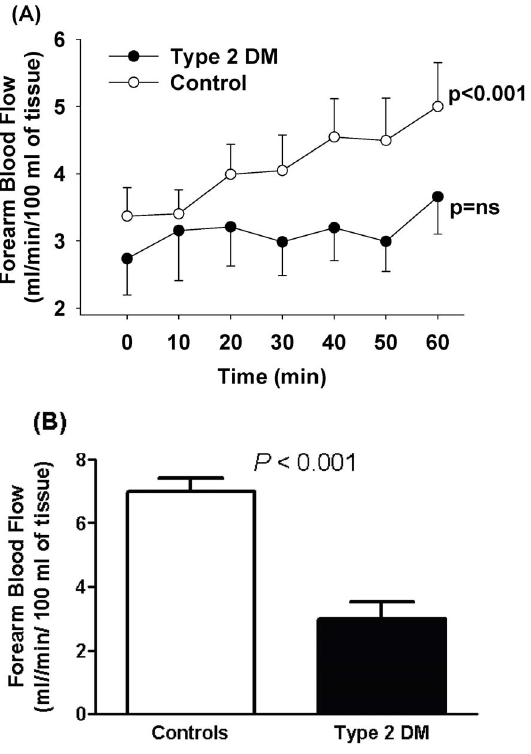
Figure 1. ( A ) Forearm blood flow responses to intra-arterial insulin infusion in controls (n=11) and type 2 diabetic subjects (n=9). Symbols and error bars represent mean 6 SEM. P values refer to 1-way RM ANOVA statistic. Type 2 DM, subjects with type 2 diabetes mellitus. ( B ) Forearm blood flow responses to intra-arterial insulin averaged over a 60 min period in controls (n=11) and type 2 diabetic subjects (n=9). Error bars are SEM. P value is the outcome of an ANCOVA.